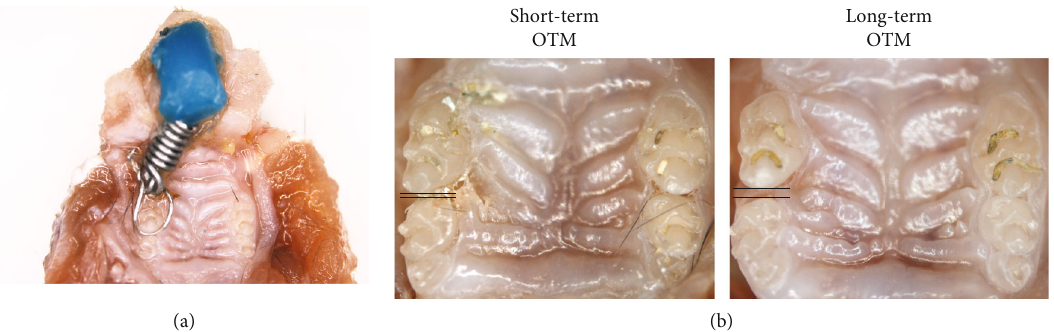
Figure 5: The OTM model and tooth movement induced by mechanical force. (a) Schematic diagram of the OTM model. (b) Tooth movement in the short-term OTM group (1 day) and the long-term OTM group (7 days).